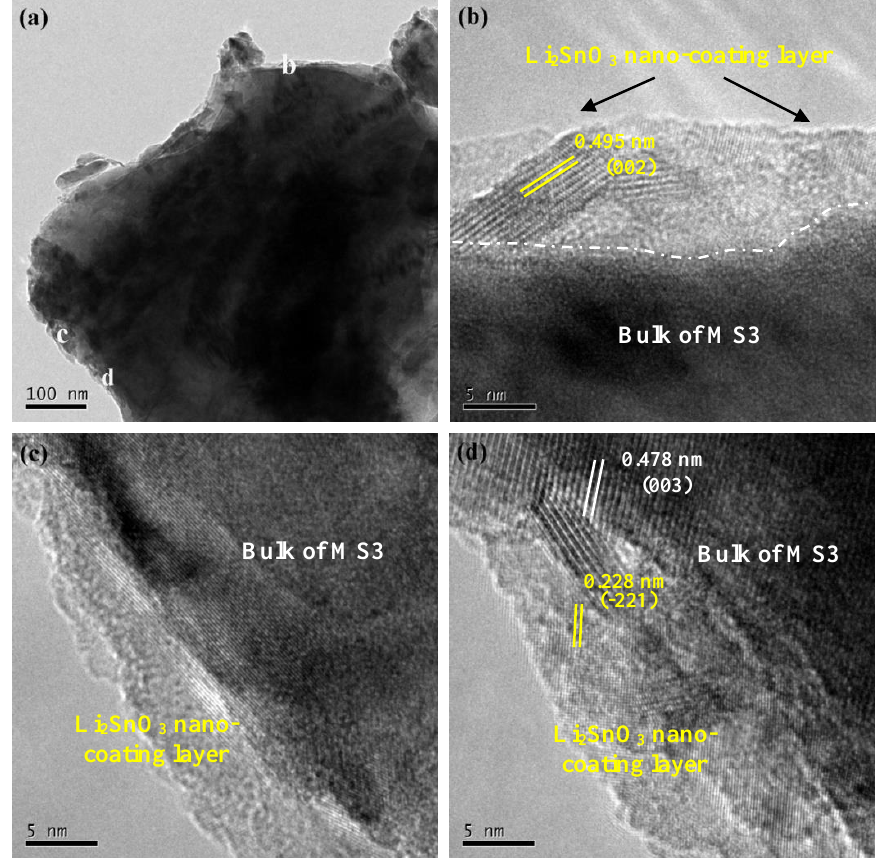
Figure 3. TEM images of MS3 ( a ) and the selected areas in Figure 3a ( b – d ).